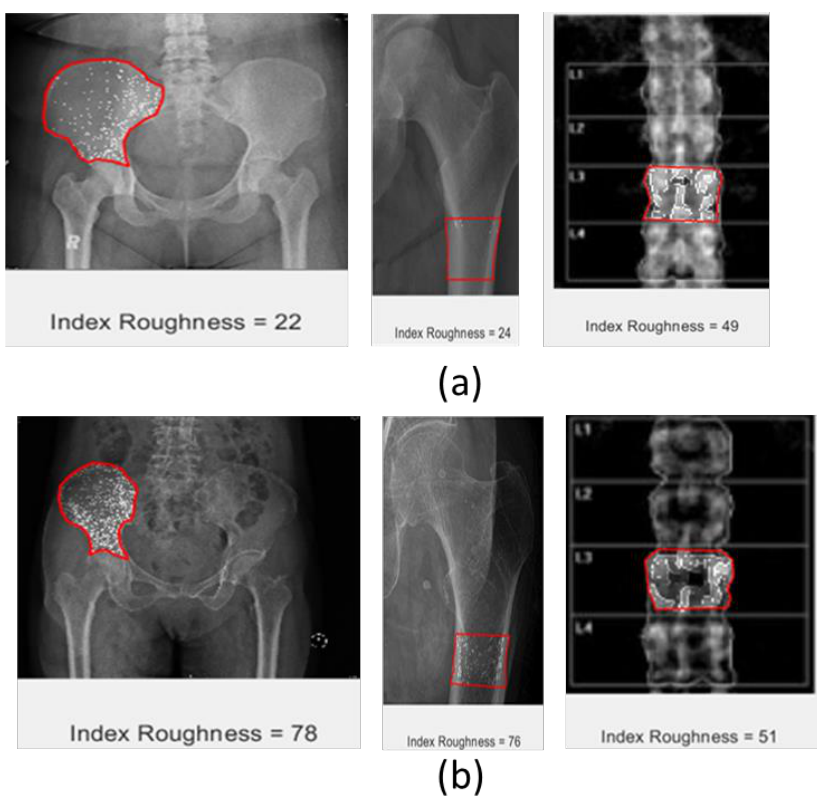
Figure 5. Roughness index of different image data of pelvic (left), hip (middle), and lumbar spine (right); ( a ) normal bone and ( b ) osteoporotic bone, red box indicate a selected